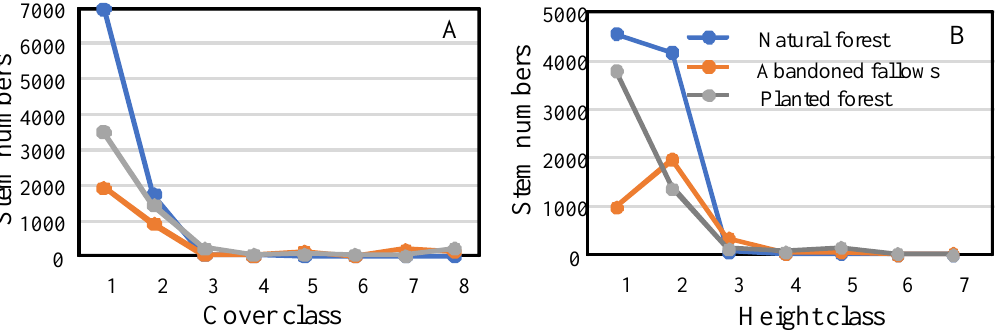
Figure 3. Variations in total abundance in different stand types across cover classes ( A ) and height classes ( B ).